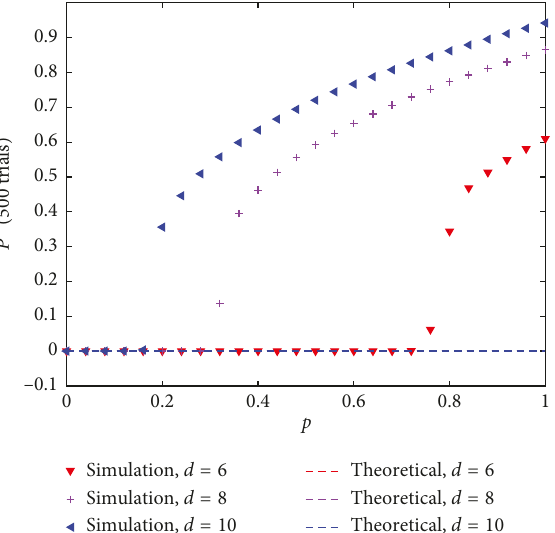
Figure 12: Validation of the correctness of the application of existing percolation theory for multilayer networks to multipartite